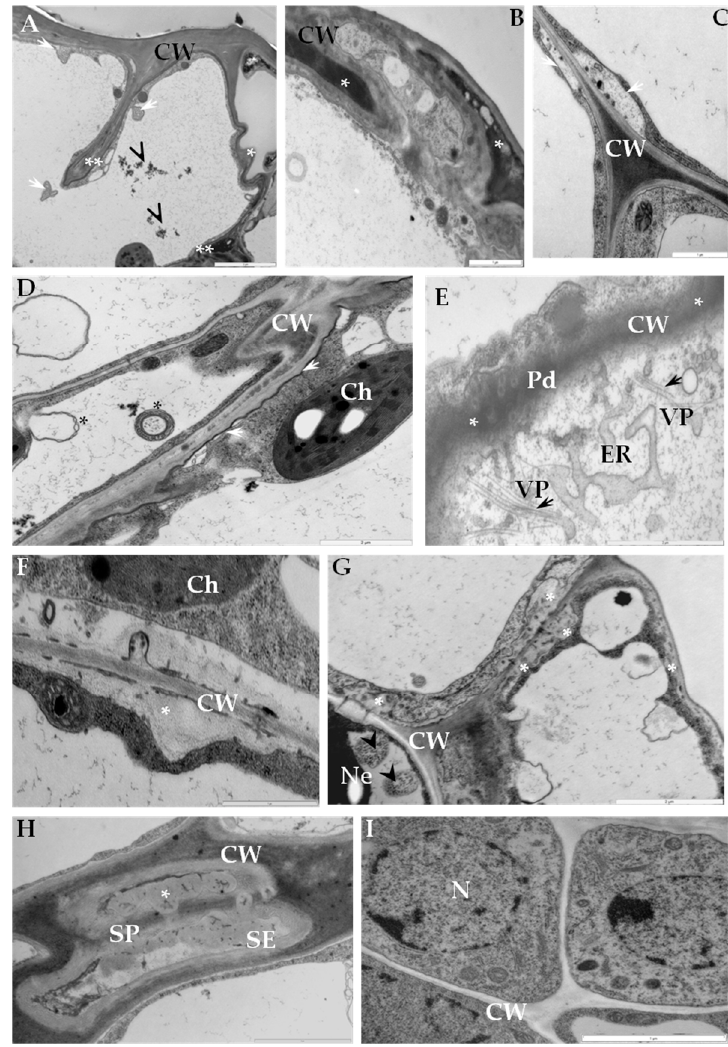
Figure 2. Ultrastructure changes in cell wall area from potato Sárpo Mira–PVY NTN interaction. ( A ) The cell wall folding (*) and invagination (**) in epidermis during HR. Multivesicular bodies (arrows) and phenolic compounds (arrowhead) presented in vacuole. Bar 2 µm. ( B ) Electron dense phenolic compounds material in reinforced epidermis cell wall (*). Bar 1 µm. ( C ) Plasma membrane retrations from cell wall (arrows) between mesophyll cells. Bar 1 µm. ( D ) Reinforced cell wall between mesophyll cells, phenolic compounds as a layer between plasma membrane and cell wall (arrows). Multivesicular bodies in vacuole (*). Bar 2 µm. ( E ) Expanded plasmodesmata area, enlarged endoplasmic reticulum, virus particles associated with membranous structure of ER (arrows). Phenolic compounds as an electron dense cell wall (asterisk). Bar 2 µm. ( F ) Callose material deposition between cell wall and plasma membrane in mesophyll cells. Bar 1 µm. ( G ) Callose deposition (asterisk) between phloem parenchyma cells. Multivesicular